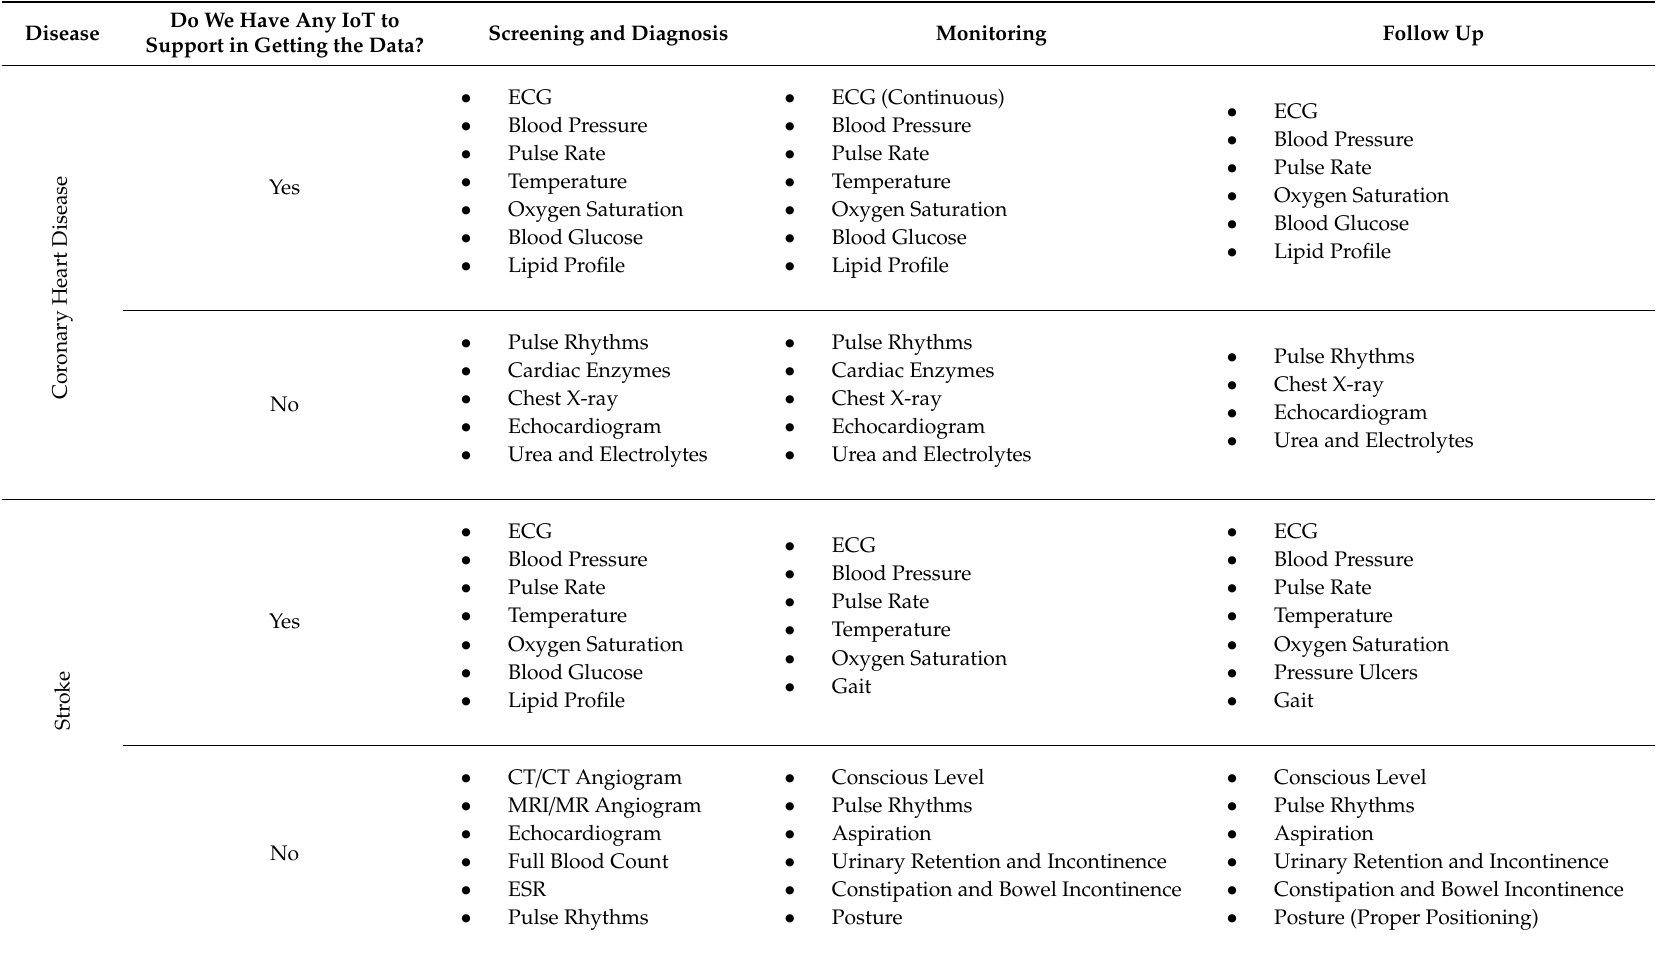
Table A2. IoT availability for data collection in the identified